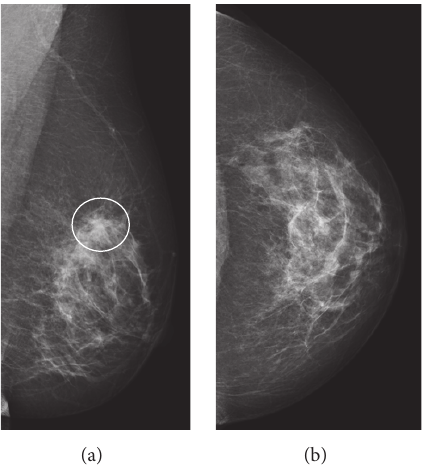
Figure 1: Left breast mammography, mediolateral oblique (a) and craniocaudal views (b). There is an architectural distortion in the upper quadrants of the left breast (white circle), not clearly seen in the craniocaudal view: Rocha A, Servicio de Radiologia, Hospital Povisa, Vigo, Spain.